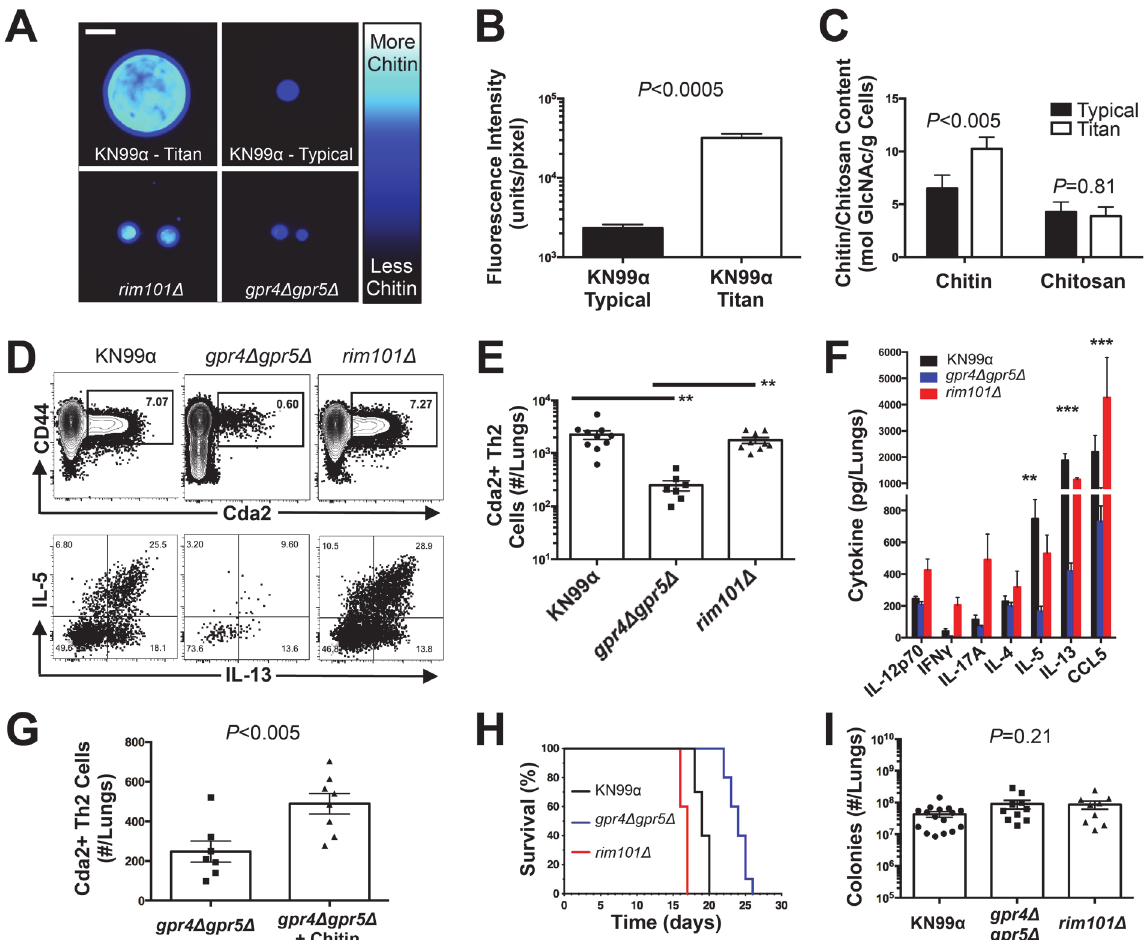
Fig 5. neoformans Chitin Correlates with Type-2 Helper T Cell Response and Subsequent Disease. ( A&B ) Cryptococcal cells isolated from lungs at 14 days post-infection and stained with Calcofluor White. Cells were either imaged with epifluorescence microscopy ( A ) or analyzed by flow cytometry with fluorescence intensity calculated per pixel to determine chitin density within the cell wall ( B ). ( C ) Total chitin and chitosan content normalized to dry weight of cryptococccal cells. ( D ) Flow cytometry plots of CD4+, Foxp3-, CD44+ Cda2+ Th cells expressing Th2 cytokines, IL-5 & IL-13, at 14 days post-infection and ( E ) the quantification of these plots. ( F ) Cytokines from lung homogenates of mice 14 days post-infection. ( G ) IL-5+ IL-13+ antigen-specific Th2 cells from lungs of mice 14 days post-infection without and with intranasal chitin particle treatment. ( H ) P -value represents log-rank test comparing each survival curve with 10 mice per group to: gpr4 Δ gpr5 Δ vs. KN99 α , P < 0.0005; gpr4 Δ gpr5 Δ vs. rim101 Δ , P < 0.0005; KN99 α vs. rim101 Δ , P < 0.0005. ( I ) Fungal burden in the lungs at 14 days post-infection. Data are presented as the mean +/- standard error with at least 2 independent experiments per group. ** = P < 0.005, *** = P < 0.0005 by Mann-Whitney U or Kruskal Wallis ANOVA. Cda = chitin deacetylase, CCL = chemokine ligand, GlcNAc = N -acetylglucosamine, IFN = interferon, IL =